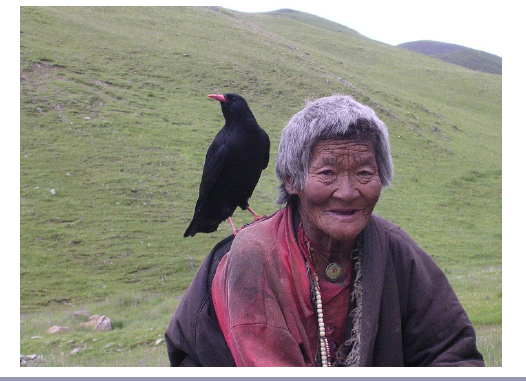
Fig. 3 . A red-billed chough ( Pyrrhocorax pyrrhocoraxsits ) on a Tibetan widow’s shoulder. The local people believe that the bird is the reincarnation of the woman’s daughter. (Photo by Tashi